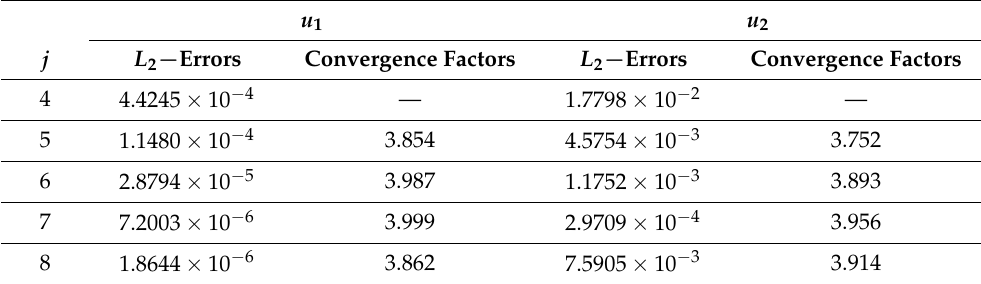
Table 4. Error estimates in L 2 norm and convergence factors. u